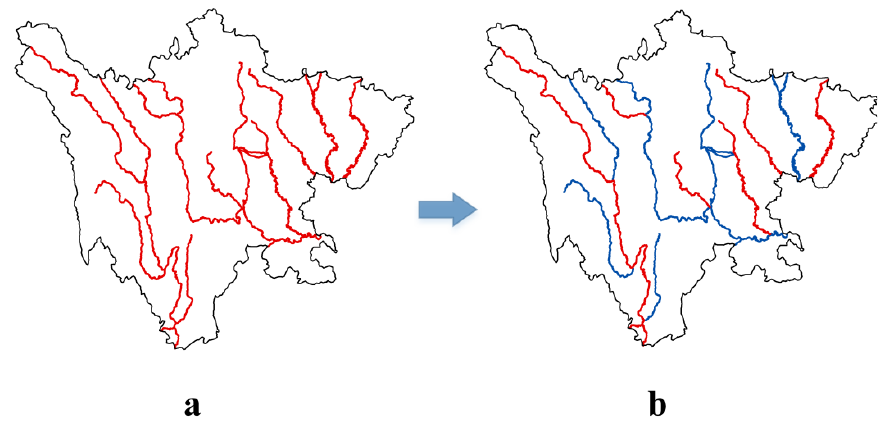
Figure 11. Replacing some large-scale geographic features into a small-scale map. ( a ) Original small-scale map. ( b ) Mixed map. (The red polylines are the original small-scale geographic features with a scale of 1: 2,000,000; the blue polylines represent “Wrong Data” on a large scale, with a scale of 1: 750,000.)